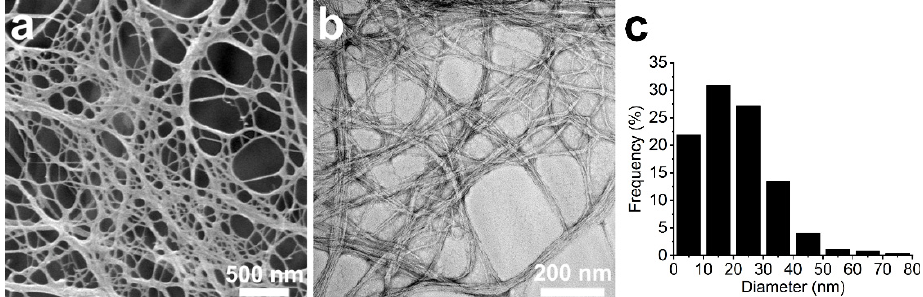
Figure 2. Cellulose nanofibers. ( a ) FESEM and ( b ) TEM images, and ( c ) the size distribution of the CNFs used as a raw